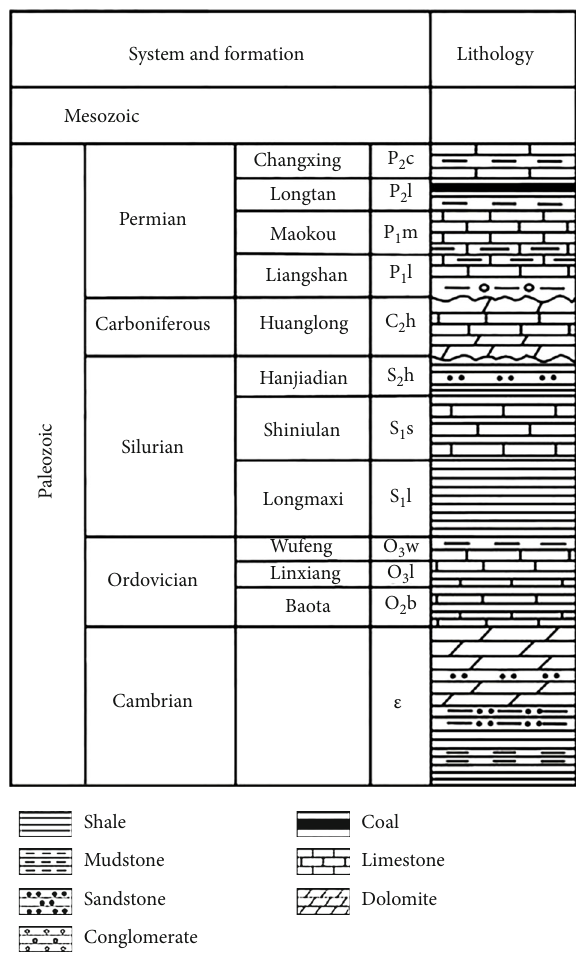
Figure 2: Schematic diagram showing the formation system and lithologic pro fi le of the investigation area (modi fi ed after